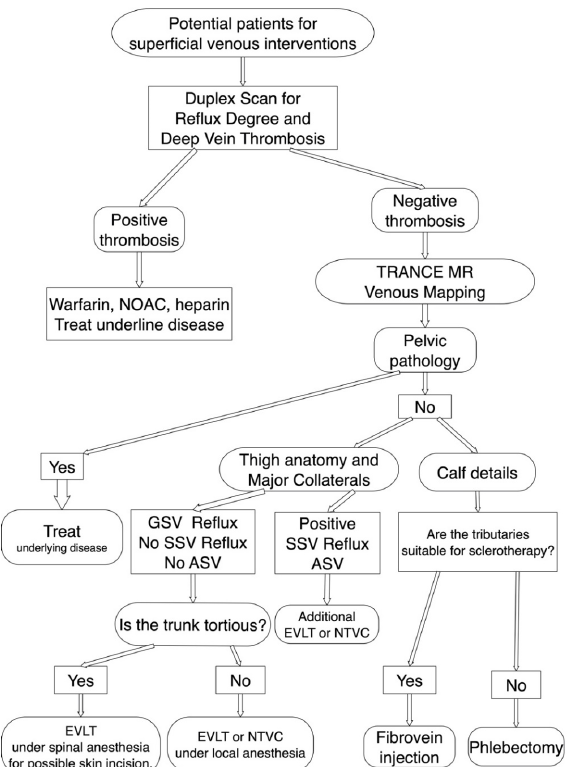
Figure 2. TRANCE MRI venous mapping appliance for preoperative assessment of the superficial venous intervention. Duplex scan was performed first to exclude deep venous thrombosis. If the superficial venous intervention is indicated, we arranged TRANCE MRI mapping to exclude pelvic pathology. Meanwhile, we assess the truncal anatomy, accessory saphenous veins and calf tributaries though TRANCE MRI for complete surgical planning. ASV, accessory saphenous vein; EVLT, Endo-venous Laser Treatment; GSV, great saphenous vein; NOAC, non-coumadin oral anticoagu- lant; NTVC, non-thermal venous closure; SSV, short saphenous vein. In this study, we included 10 healthy controls and compared the QFflow analysis findings of the patients who received TRANCE-MRI-guided interventions in their left leg with the left legs of the controls. SV was higher in the EIV ( p = 0.021) in the left-leg-inter- vention group. The MF was higher in the EIV ( p = 0.012) and tended to increase in the GSV ( p = 0.087) in the left-leg-intervention group. SD was longer in the EIV segments ( p = 0.019). The QFlow of 10 patients who received interventions in their right leg was analyzed, and SV ( p = 0.002), FFV ( p = 0.001), and MF ( p = 0.001) in the GSV were higher in the right-leg- intervention group. We suppose that the patients with venous reflux who were willing to